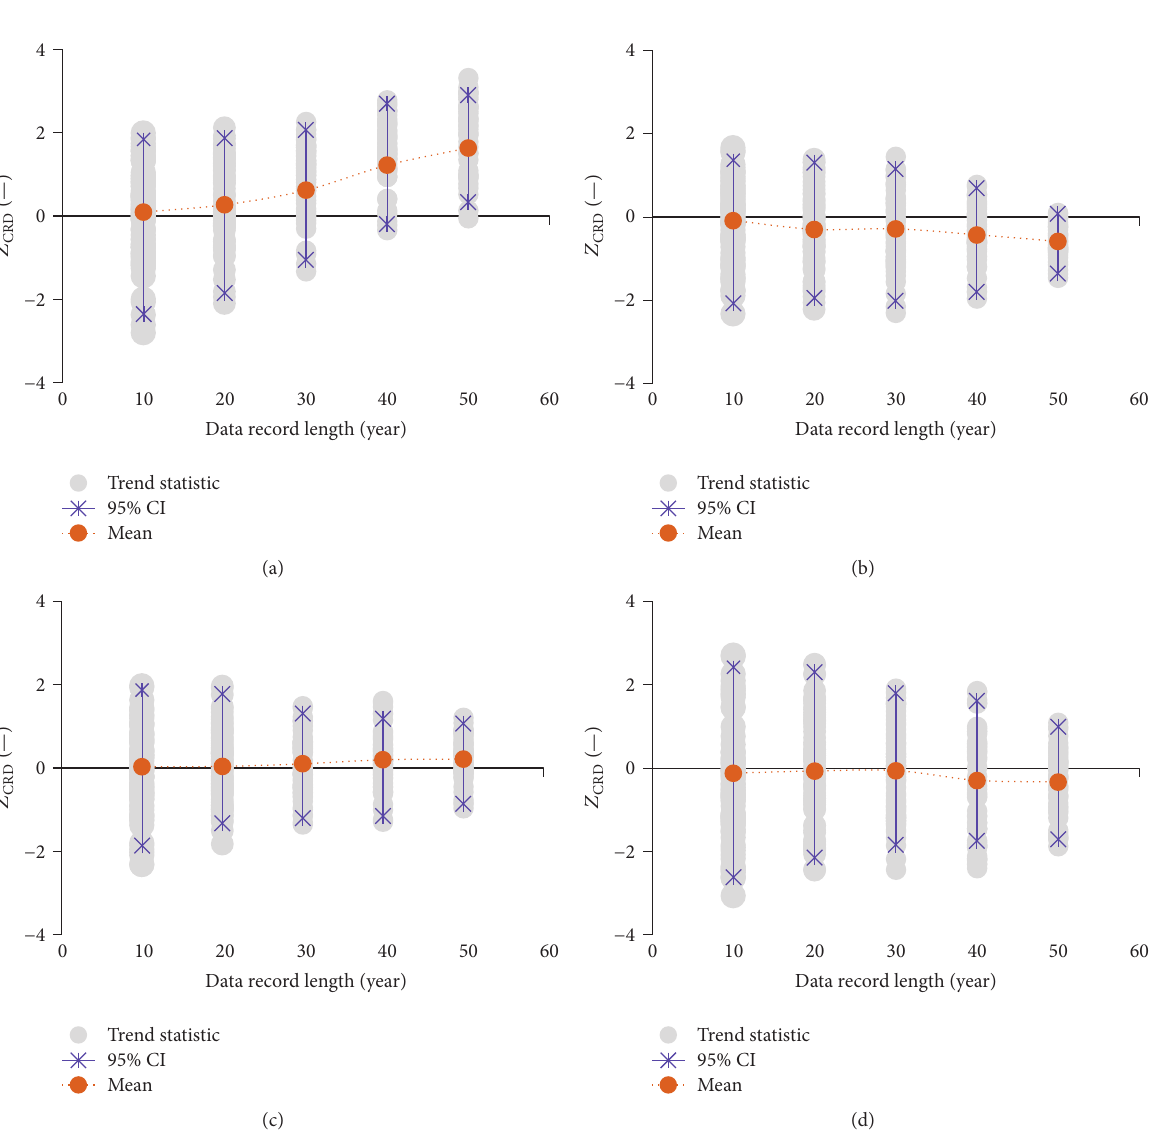
Figure 6: Uncertainty on the mean estimate of the population trend statistic assessed using various record lengths of annual rainfall at station: (a) 4, (b) 10, (c) 12, and (d)